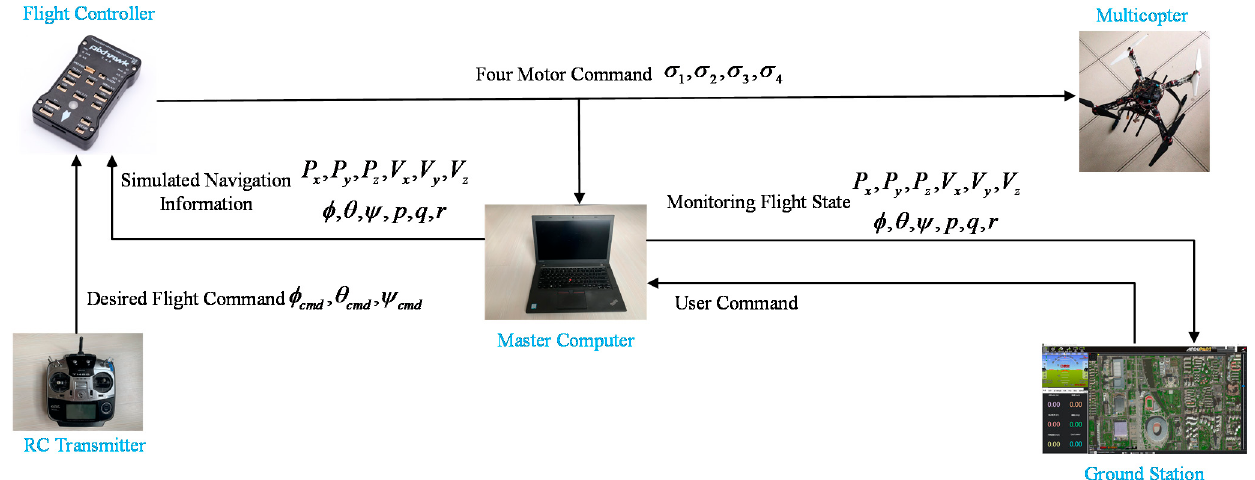
e . ( b ) Fuzzy membership functions for input